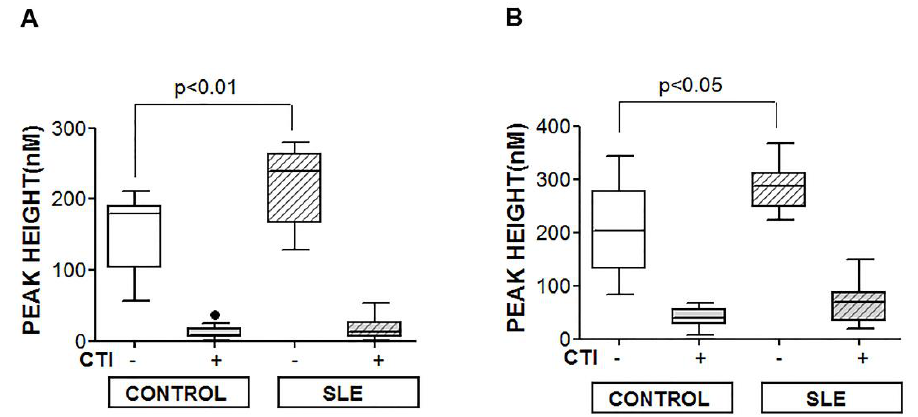
Figure 5. Thrombin generation associated with NETs. The effect of NETs on the thrombin generation was tested in either non-stimulated ( A ) or 100 nM of PMA-stimulated neutrophils ( B ) in the presence of PRP from healthy controls adjusted to 1 × 10 5 platelets/µL, with (+) or without (−) CTI. Detailed procedures are explained in “Materials and Methods”. A Mann–Whitney test was performed, and p < 0.05 was considered significant.